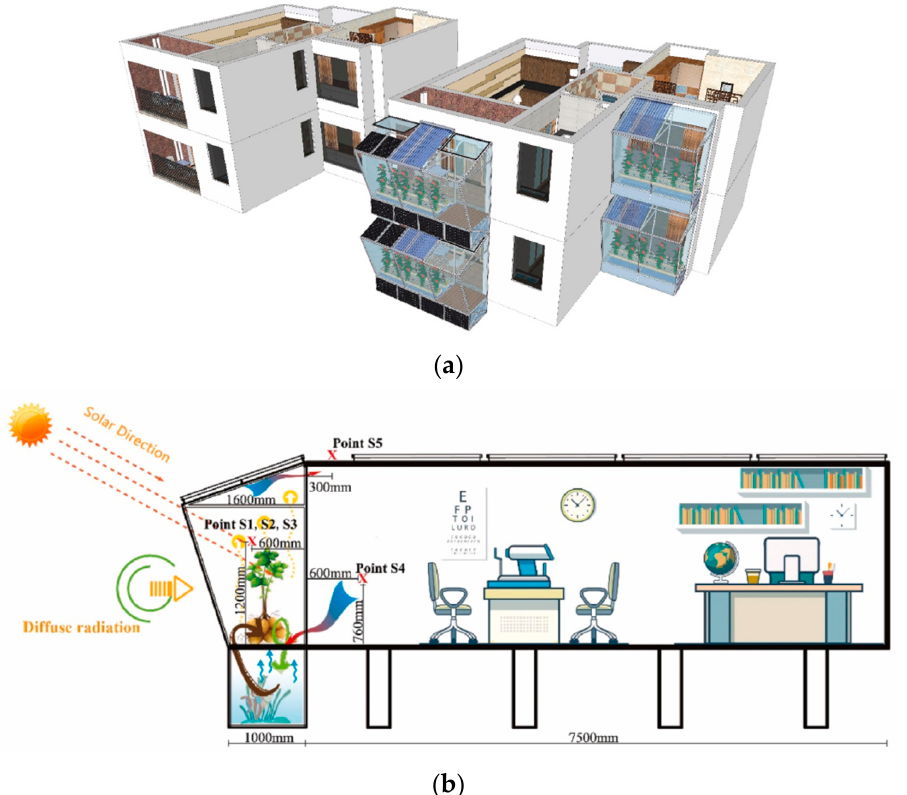
Figure 19. Productive double façade concept: ( a ) General view of the building; ( b ) Structural section (data from ref. [146]) .